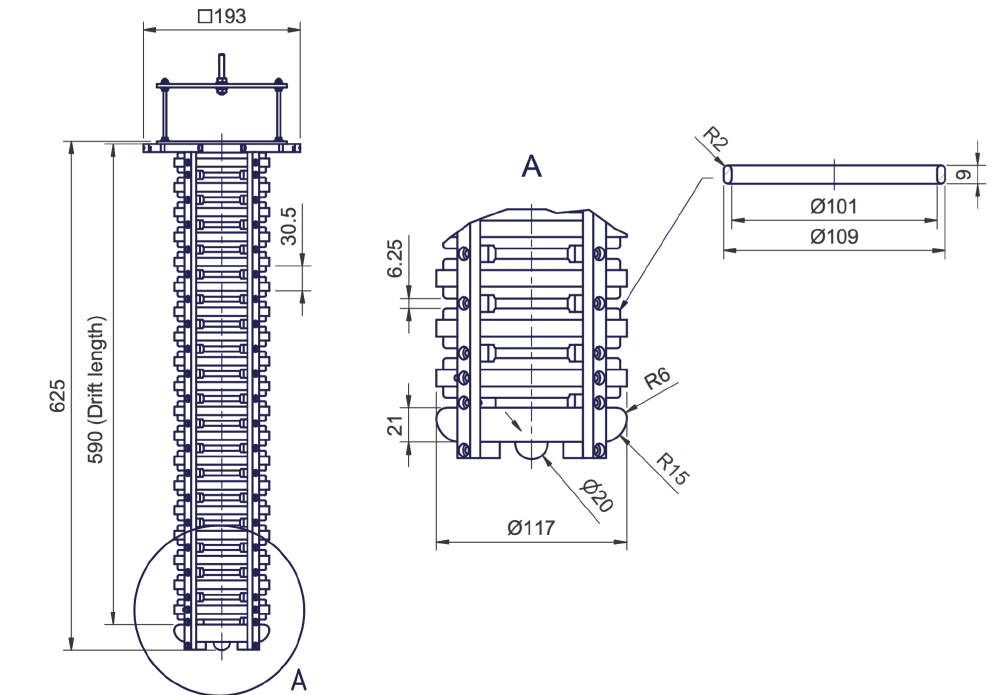
Figure 4. Engineering drawing of the pixel demonstration TPC; 590mm drift length; 6.25mm field cage spacing; 101mm internal diameter.